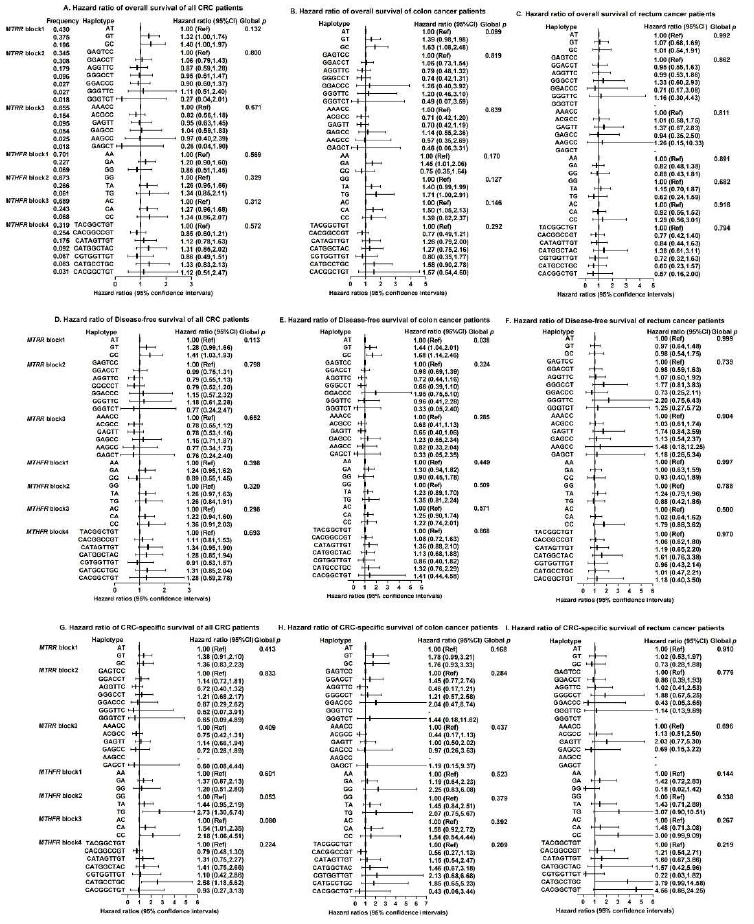
Figure 2. Haplotypes on MTRR and MTHFR genes and associations with overall survival, dis- ease-free survival and CRC-specific survival among colorectal cancer patients ( A – I ). Abbreviations: CRC = colorectal cancer; MTRR = methionine synthase reductase; MTHFR = methylenetetrahydro- folate reductase; Ref = Reference; CI = confidence interval. MTRR , block1 includes rs1801394 and rs13181011. MTRR , block2 includes rs326124, rs1532268, rs7703033, rs6555501, rs162031 and rs162033. MTRR , block3 includes rs161871, rs162040, rs3776455, rs10380 and rs9332. MTHFR , block1 includes rs4846048 and rs2184226. MTHFR , block2 includes rs4846049 and rs1476413. MTHFR , block3 includes rs1801131 and rs12121543. MTHFR , block4 includes rs1801133, rs1572151, rs4846052, rs2066471, rs13306567, rs7533315, rs9651118, rs7553194 and rs13306561. Haplotype fre- quency is calculated based on the n = 532 sample. Cox proportional hazard models were adjusted for age at diagnosis, sex, stage at diagnosis, race, drink status, body mass index (BMI), screen sta- tus, BRAF2, microsatellite instability (MSI) status and marital status, where appropriate. 3.5. Gene-Diet Interactions To evaluate the possibility of gene-diet interactions, participants were grouped as high versus low intakes of vitamin B, fruits and alcohol based on the respective median value (Figures 3 and 4). We observed significant interactions among pre-diagnostic al- cohol consumption with several SNPs in MTRR (i.e., rs1801394, rs3776467, rs326124, rs162040, and rs3776455), with increased OS time associated with those protective variant